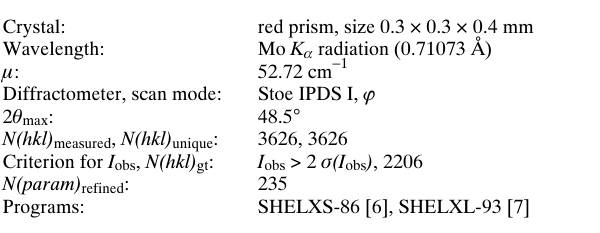
Table 1. Data collection and